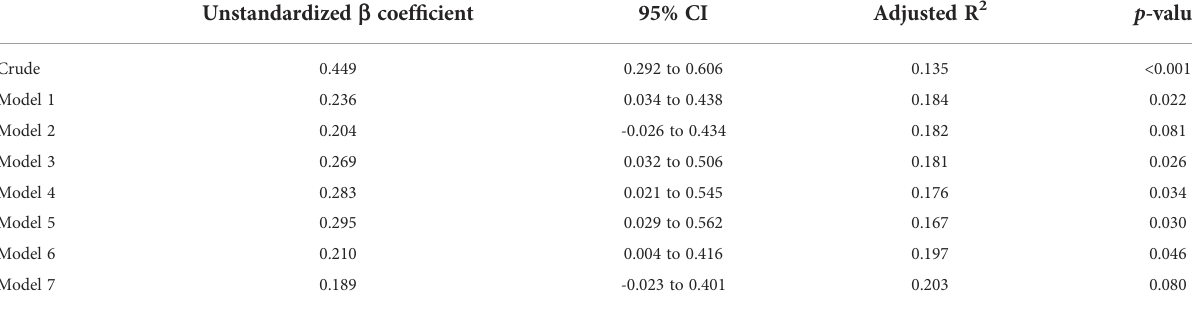
model 1 adjusted for age, sex and GFR Cystatin C. model 2 adjusted for age, sex, GFR Cystatin C, log 10 Klotho, log 10 25-hydroxyvitamin D, log 10 PTH, log 10 plasma PO 43- , log 10 urinary PO 43- .